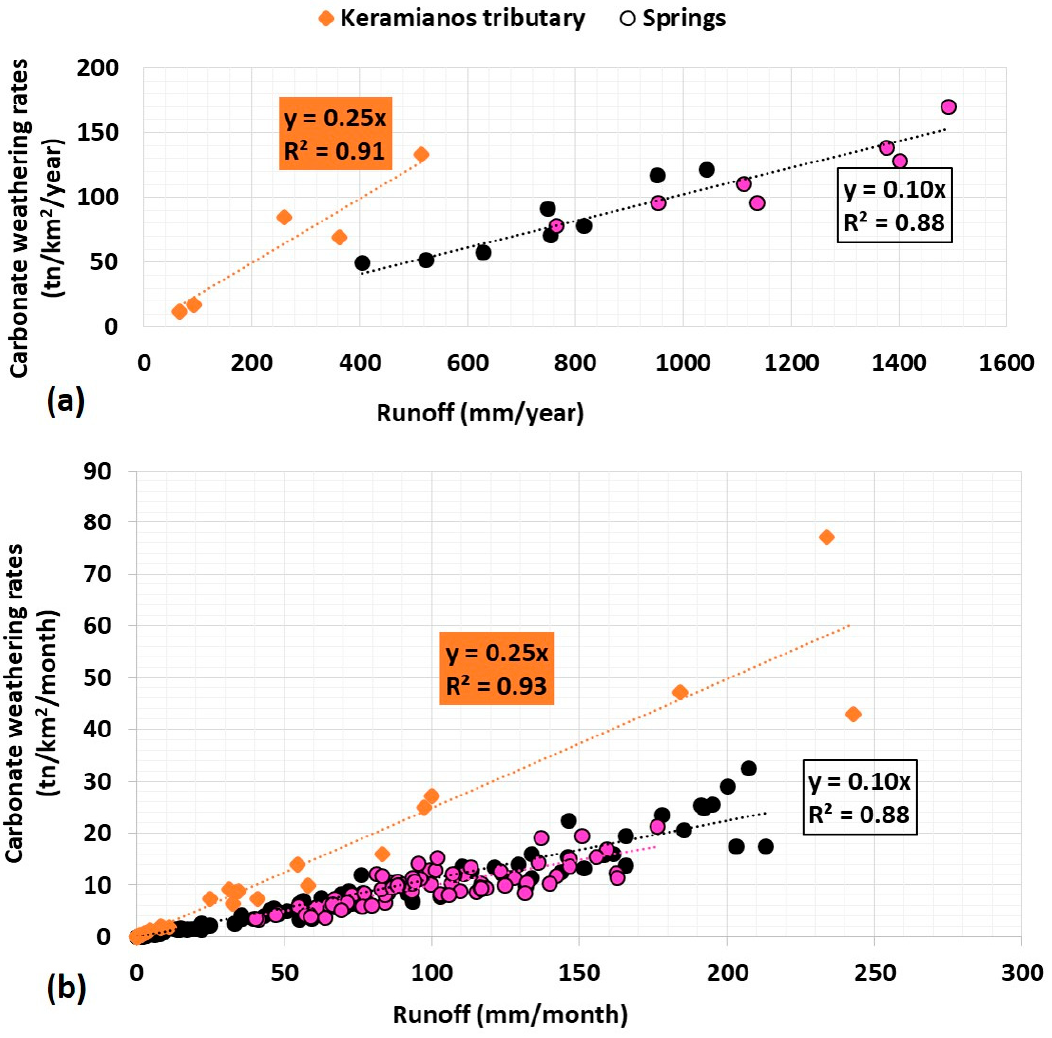
Figure 8. Relationship between ( a ) annual and ( b ) monthly carbonate weathering rates and runo ff in Keramianos river and springs of Koiliaris CZO. The black and dark pink circles depict Stylos (S1) and Armenoi (S3) springs,